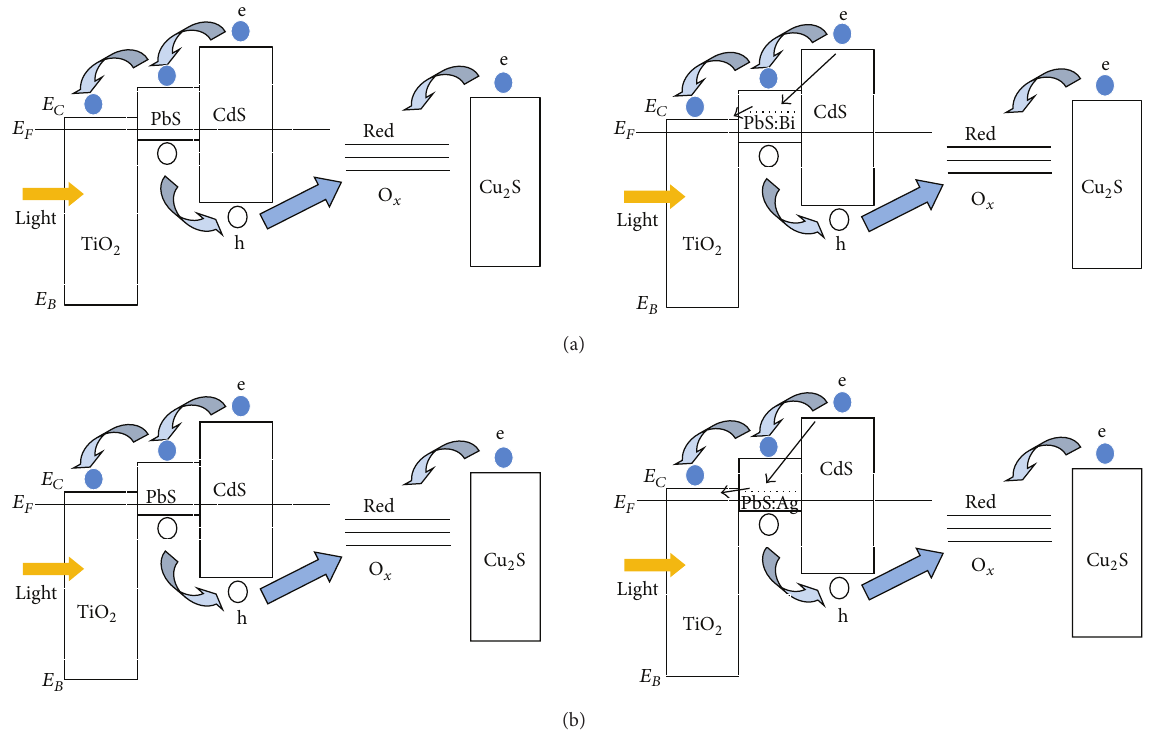
Figure 9: Schematic illustrations for internal mechanism of (a) TiO 2 /PbS/CdS and TiO 2 /Bi-doped-PbS/CdS and (b) TiO 2 /PbS/CdS and TiO 2 /Ag-doped-PbS/CdS